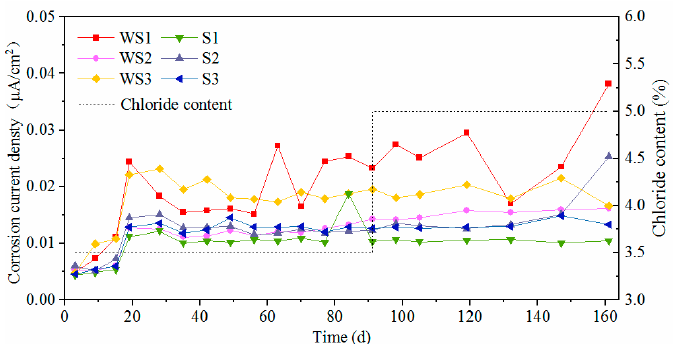
Figure 10. Corrosion current density of novel 2205 duplex stainless steel. Materials 2019 , 12 , x FOR PEER REVIEW